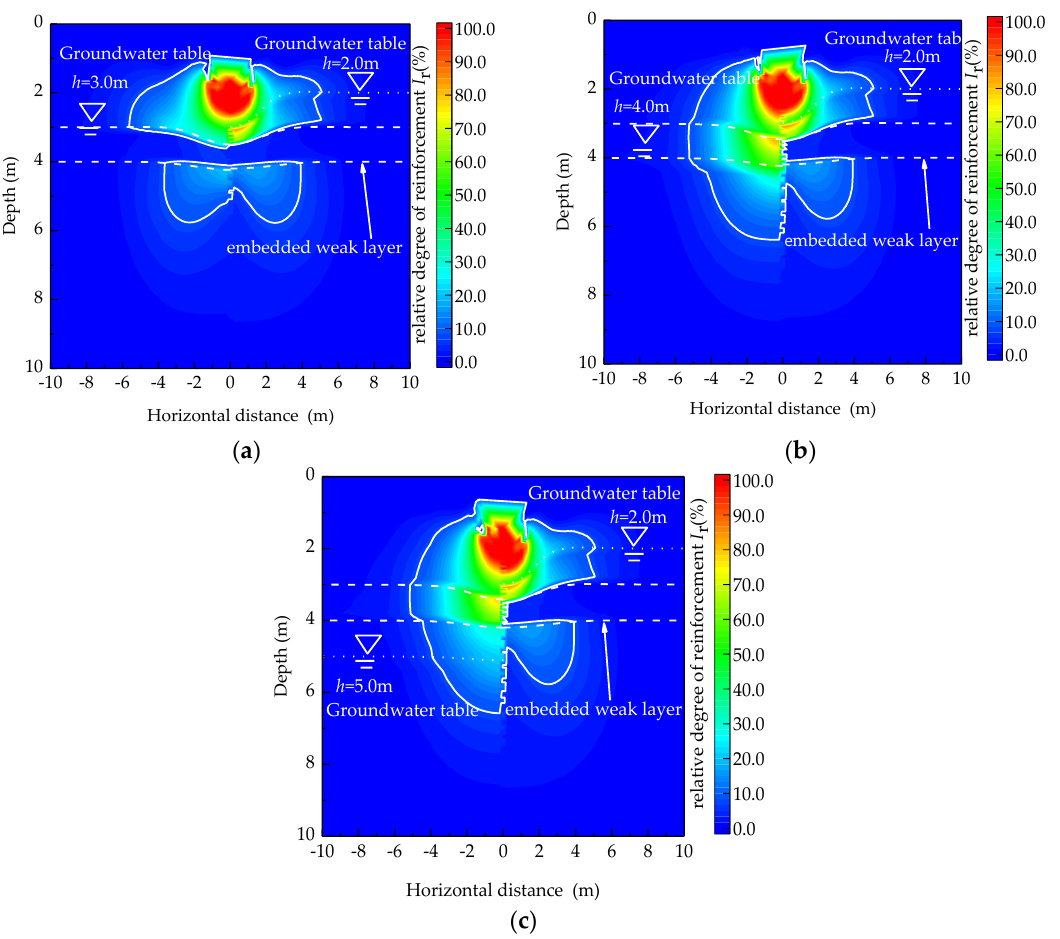
Figure 19. Distributions of I r in grounds with different levels of groundwater. ( a ) precipitation depth of 3 m; ( b ) precipitation depth of 4 m; ( c ) precipitation depth of 5 m.